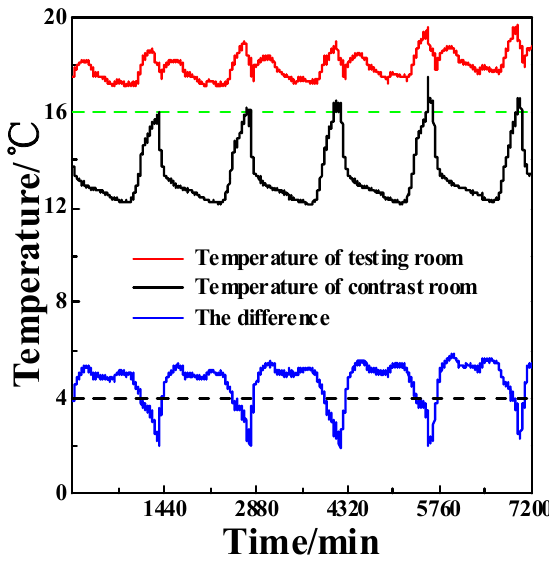
Figure 4. Diagram of temperatures in the testing room and contrast room over time.